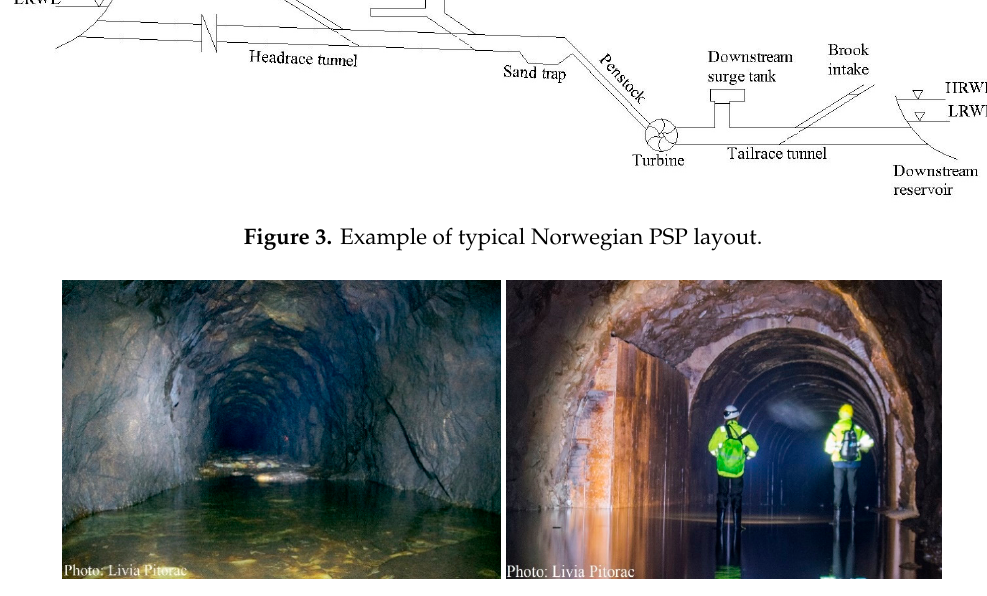
Figure 4. Typical drill and blast tunnel in Norwegian PSPs: without lining ( left ) and with lined section ( right